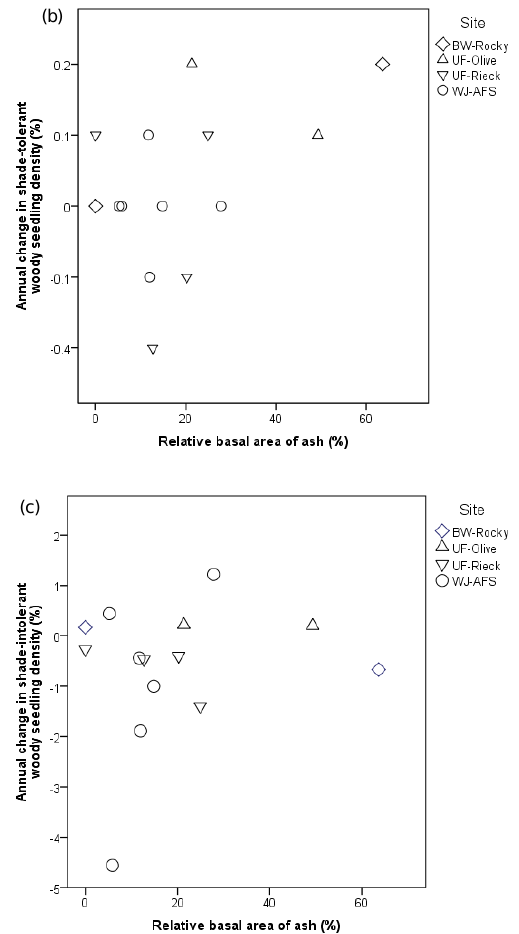
Figure 4. Effects of relative Fraxinus basal area on change in density of ( a ) woody seedlings of all species ( r 2 = 0.04. p = 0.482), ( b ) shade-tolerant species ( r 2 = 0.14, p = 0.184), and ( c ) shade-intolerant species ( r 2 = 0.03, p = 0.526).